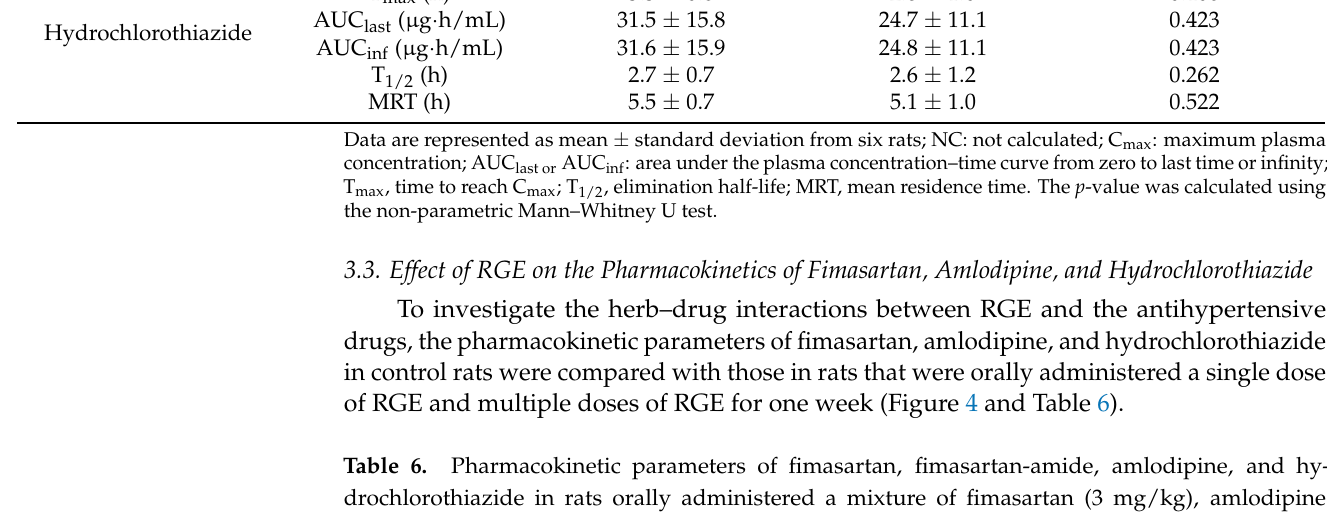
Table 6. Pharmacokinetic parameters of fimasartan, fimasartan-amide, amlodipine, and hy- drochlorothiazide in rats orally administered a mixture of fimasartan (3 mg/kg),